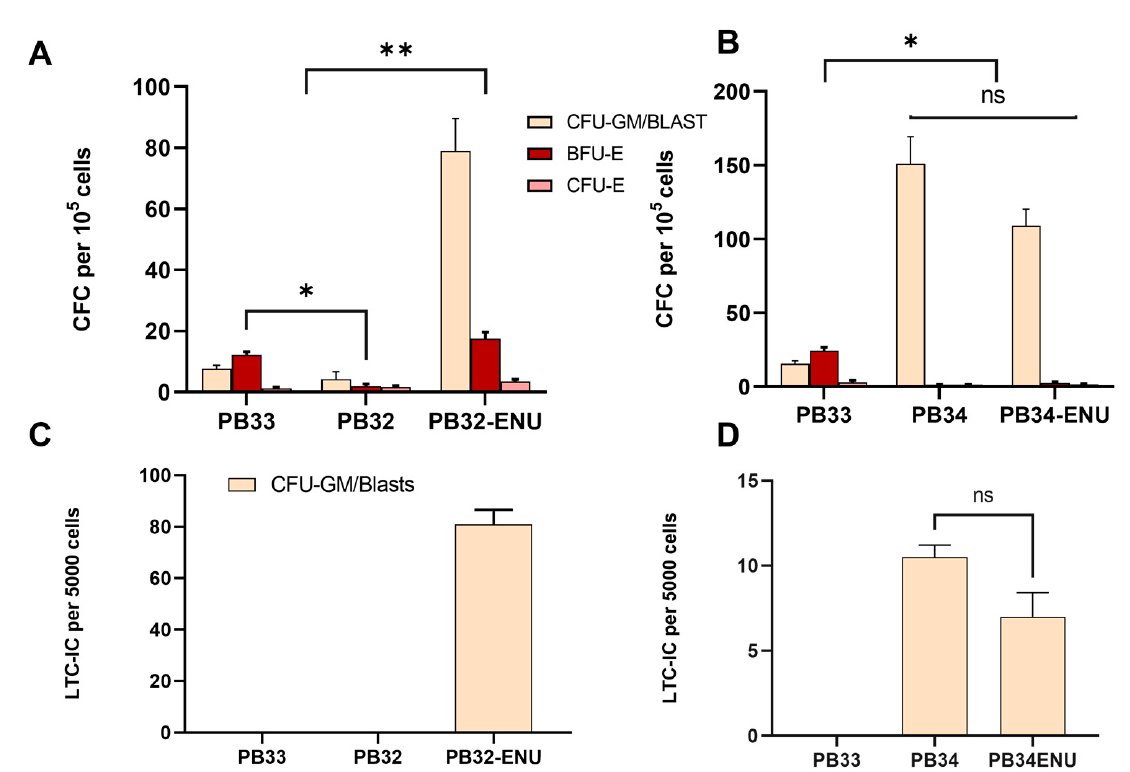
Figure 4. CFC and LTC-IC assays for mutated and unmutated cells at D13 of hematopoietic differen- tiation. ( A ) CFC assays for PB33 (WT, no BCR::ABL), PB32, and PB32-ENU according to the num- ber of colonies per 10 5 cells. ( B ) LTC-IC for PB33, PB32, and PB32-ENU according to the number of colonies per 5000 cells. ( C ) CFC assays for PB33, PB34, and PB34-ENU according to the number of colonies per 10 5 cells. ( D ) LTC-IC for PB33, PB34, and PB34-ENU according to the number of colo- nies per 5000 cells. All experiments have been performed in triplicates. The total number of colonies was compared, and P-values were calculated using a two-tailed Student’s t -test. ns, not significant; *, p < 0.05; **, p < 0.01.